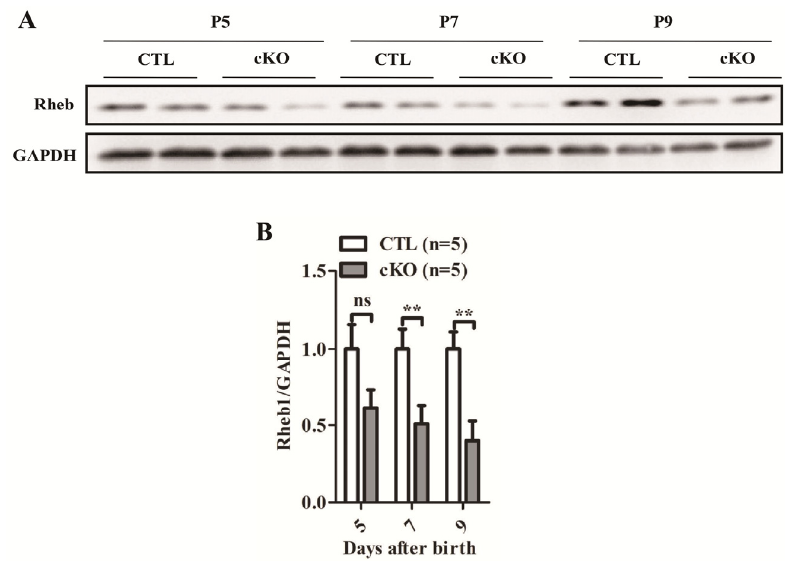
Figure 1. ( A ) Detection of deletion efficiency of Rheb1 by Western blot at postnatal day 5, 7, and 9, respectively; and ( B ) Quantification of ( A ) ( n = 5). Abbreviations: CTL, Control group ( Rheb1 F / F ); cKO, cardiac knockout group ( Rheb1 F / F ; α MHC-Cre ); ** p < 0.01, cKO versus